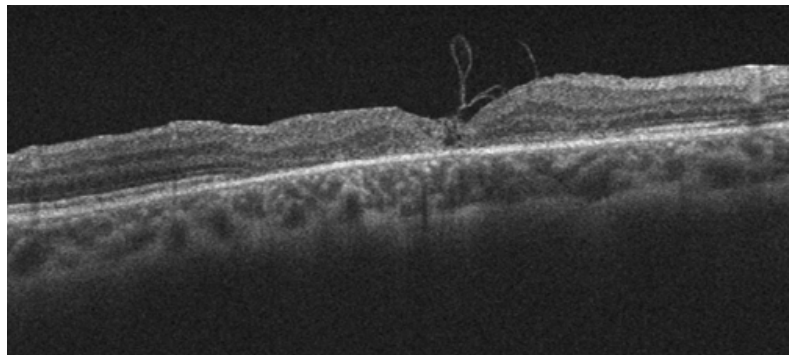
Figure 3: Optical coherence tomography 6 months postoperative showing anatomical type 1 closure of the macular